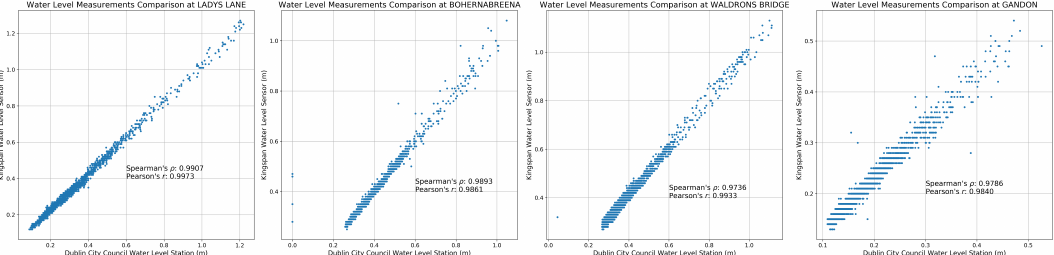
Figure 7. Correlation between the four Dublin City Council reference stations and Kingspan sensor units deployed.